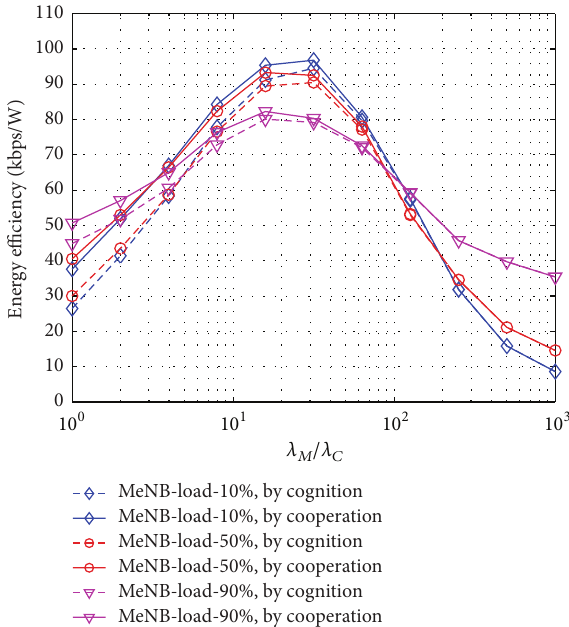
Figure 6: Energy efficiency comparison between cooperative and cognitive HetNet with different MBS